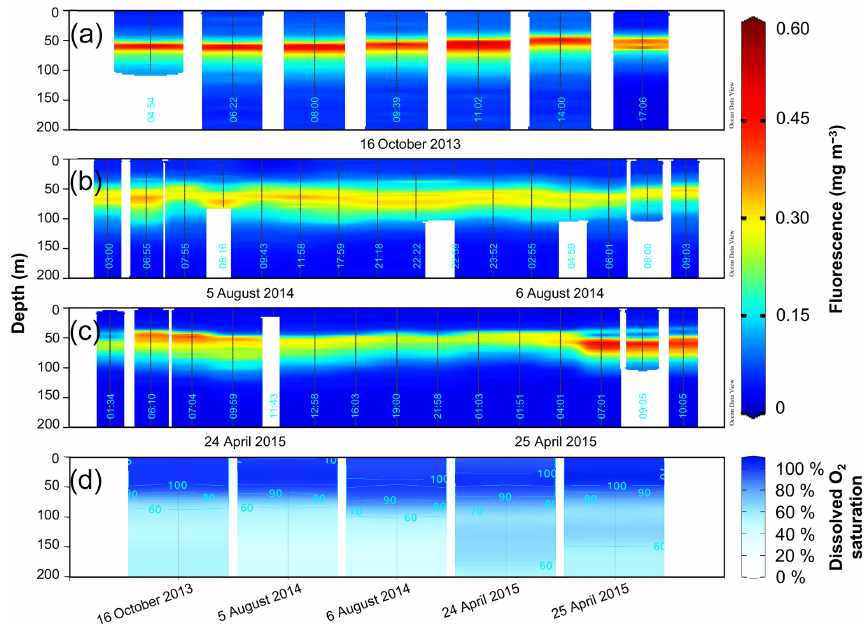
Figure 3. Fluorescence (mgm − 3 ) time series from SEATS on (a) 16 October 2013, (b) 5–6 August 2014 and (c) 24–25 April 2015. (d) Depth profiles of dissolved O 2 saturation (%) during the different sampling days, calibrated to manual dissolved O 2 measurements. Data visualiza- tion was done using Ocean Data View (https://odv.awi.de/, Schlitzer, 2020).